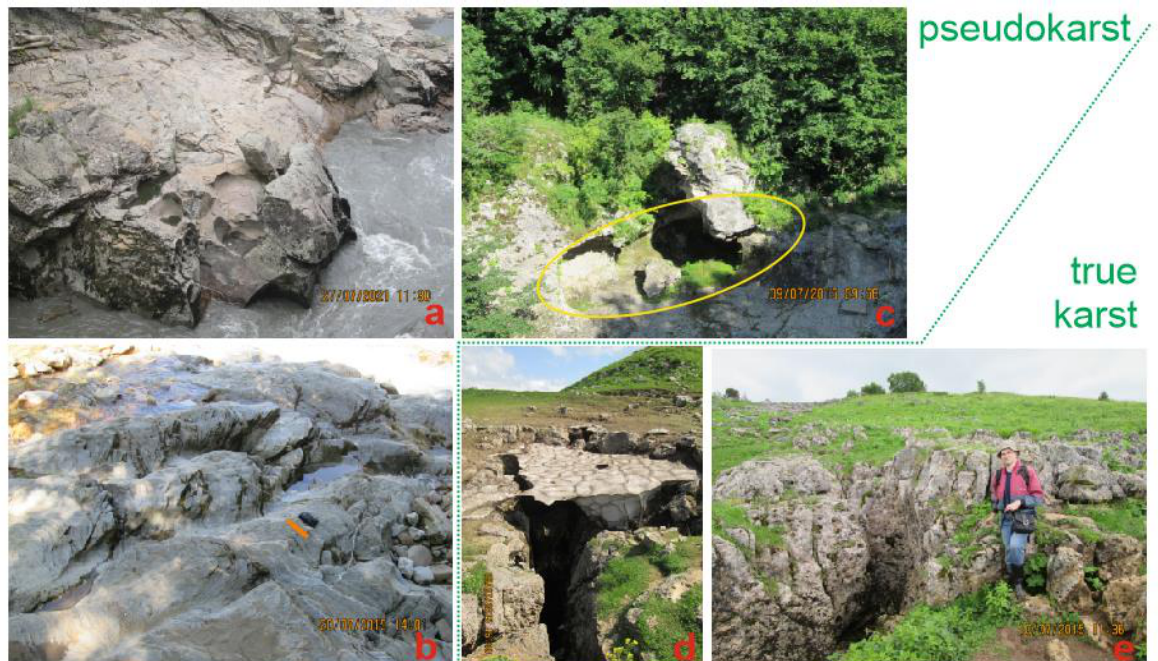
Figure 5. Other comparable features from the study area: ( a ) potholes in the Lower Triassic limestones created by the Belaya River, ( b ) small potholes and channels in the Upper (?) Triassic limestones (the camera highlighted in orange is ~10 cm in size) created by the Sakhray River, ( c ) pothole in the Upper Jurassic limestones (indicated by yellow oval) created by the Belaya River, ( d , e ) epikarst fissures in the Upper Jurassic limestones (the size of the shown plots is ~25 m 2 ) in the Lagonaki Highland.